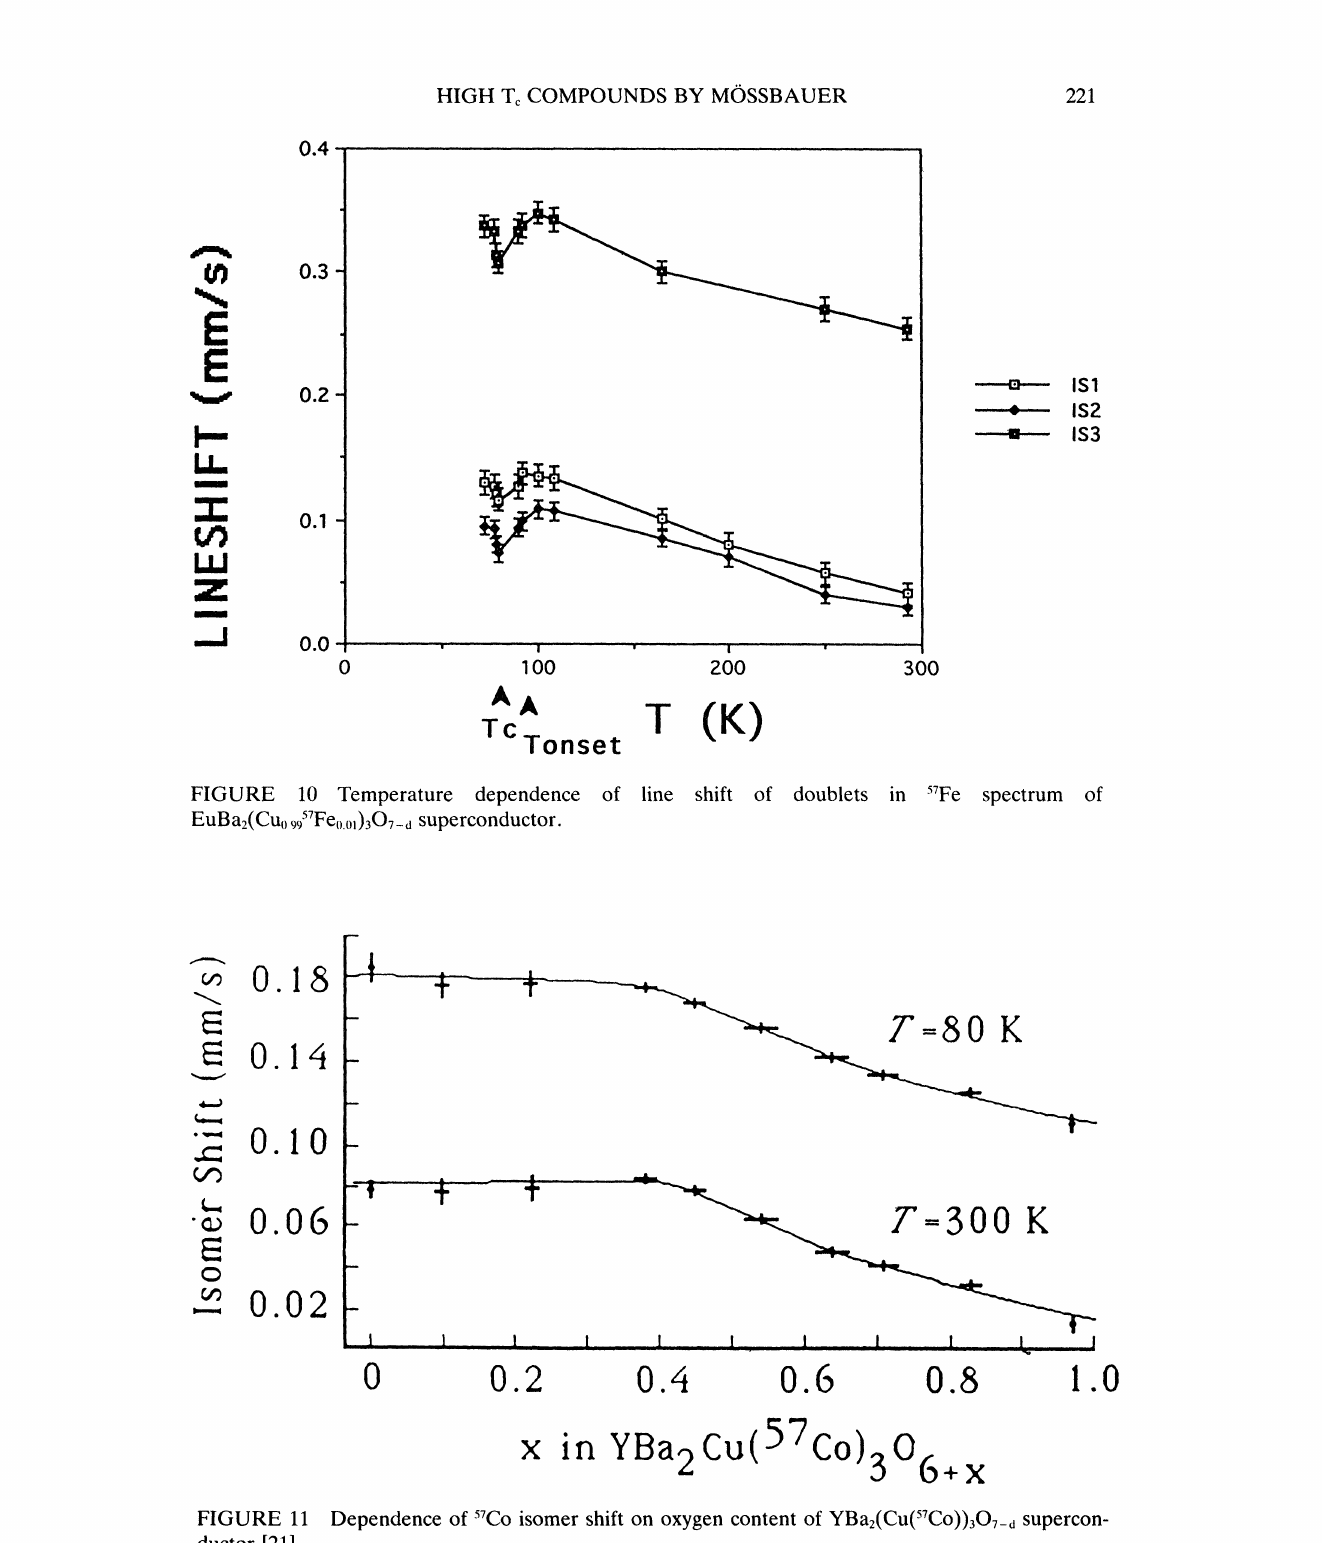
FIGURE 11 Dependence of 57C0 isomer shift on oxygen content of YBa2(Cu(-TCo))3OT_d supercon- ductor